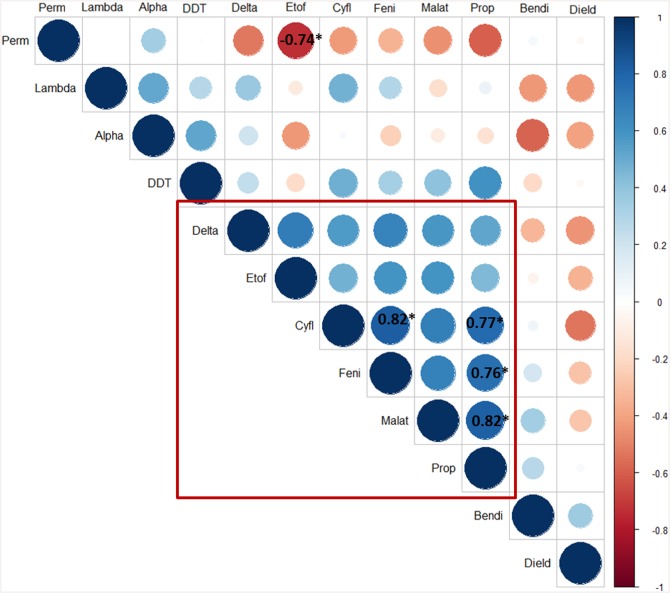
Schematic illustration of correlation between insecticide mortality rates (mean of 24h mortality per insecticide for all stations).Positive correlations are in blue and negative correlations are in red. The intensity of colors and the size of circles are proportional to the correlation coefficient. In the right, the color legend shows the correlation coefficient values with corresponding colors. Numbers followed by star are significant p values (p<0.05). Positive correlations between insecticides are represented surrounded with red rectangle.